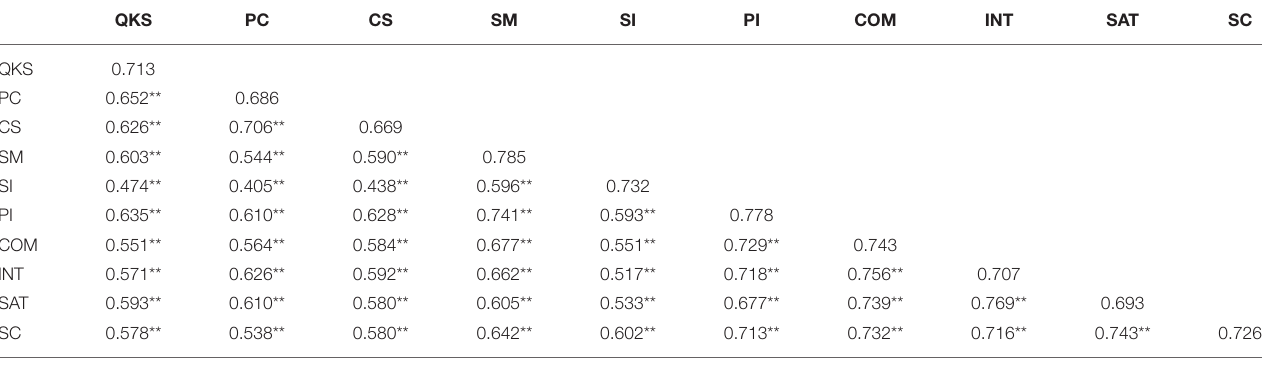
TABLE 3 | Correlation coefficient and discrimination validity.